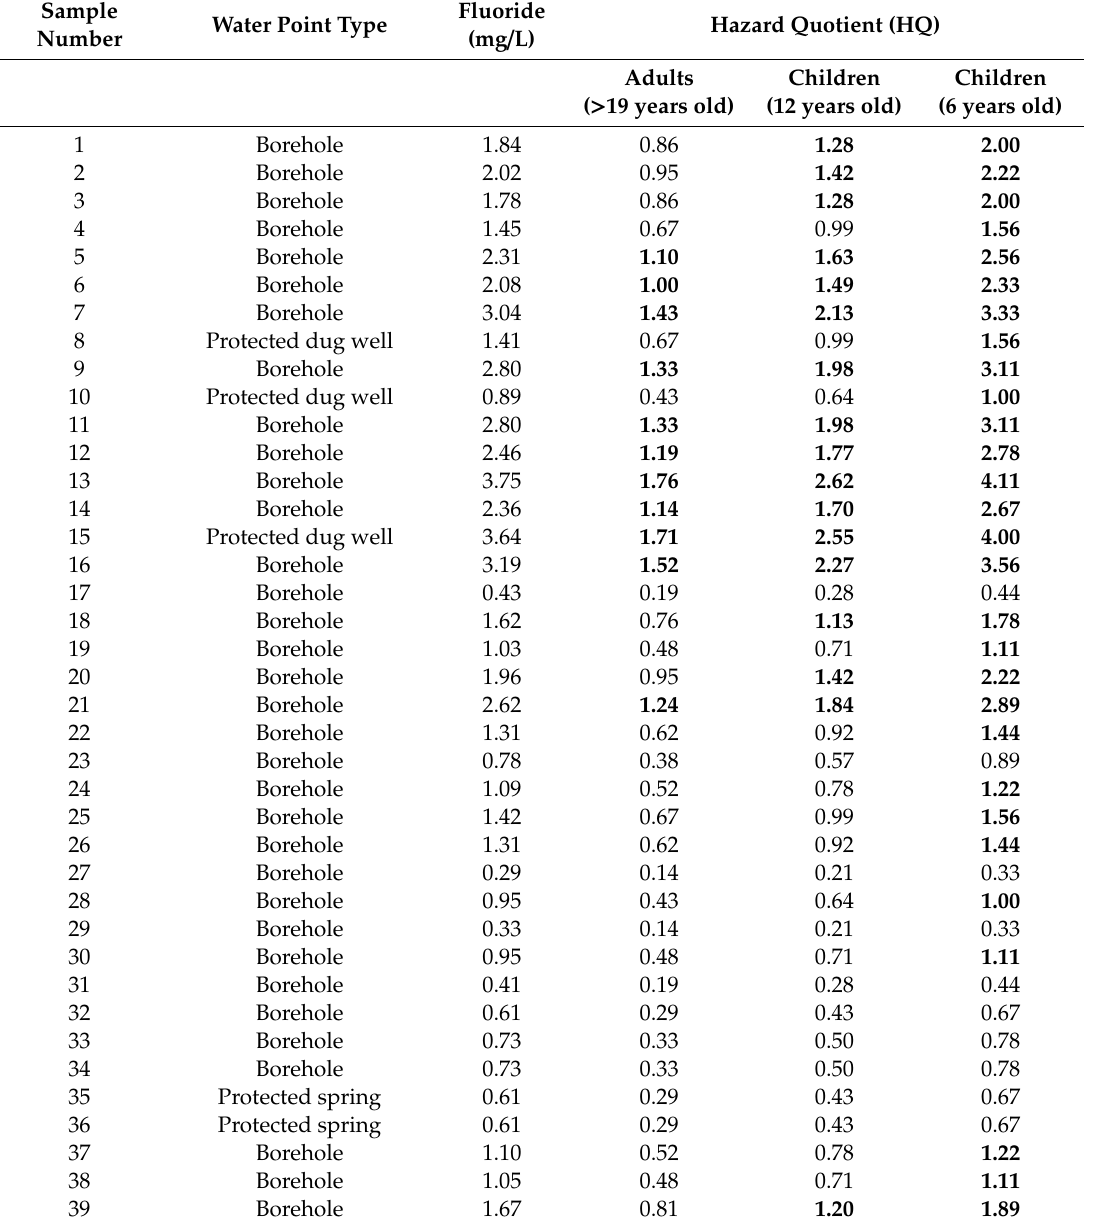
Table 3. Calculated HQ values for each age group and each water point from the study area. HQ values > 1 shown in